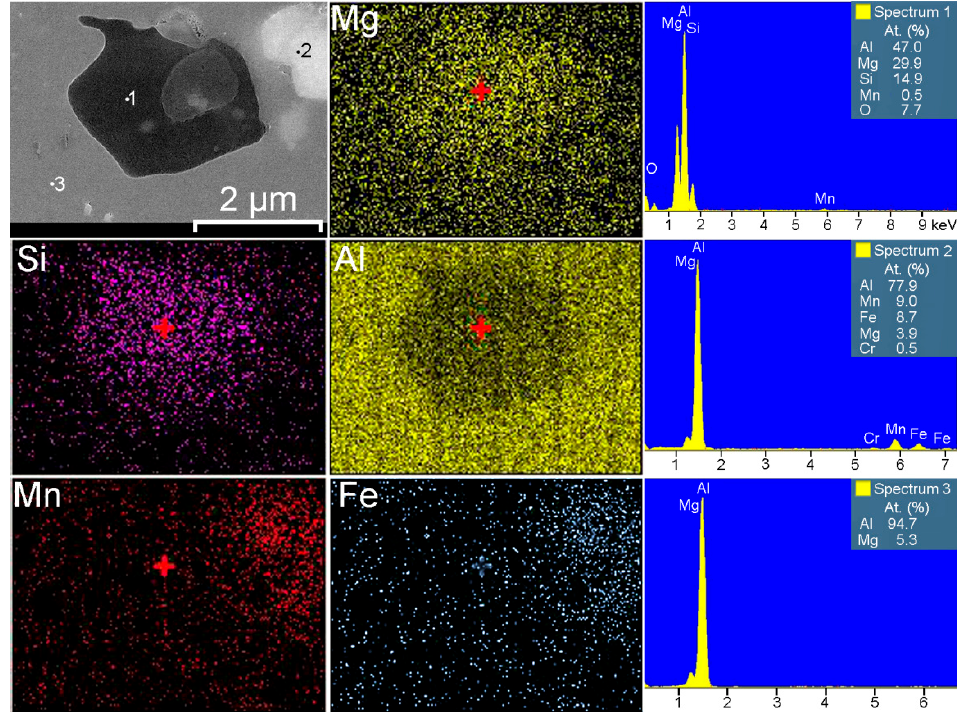
Figure 7. Detailed SEM-EDX analysis of black spots in the HAZ. Presence of Mn-Fe-Al and Mg-Si phases was detected.